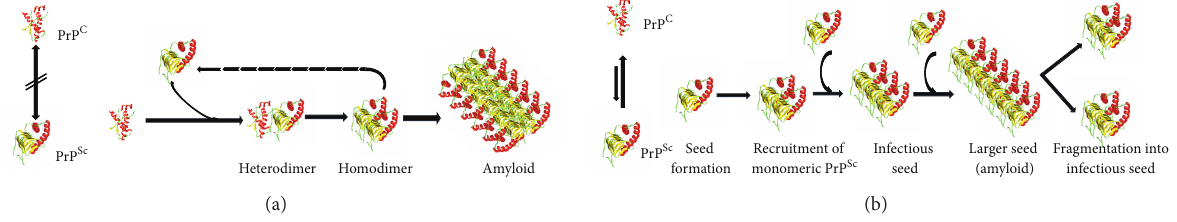
Figure 2: (a) The “template-assistance model” [8] and (b) the “seeding nucleation model” [9].